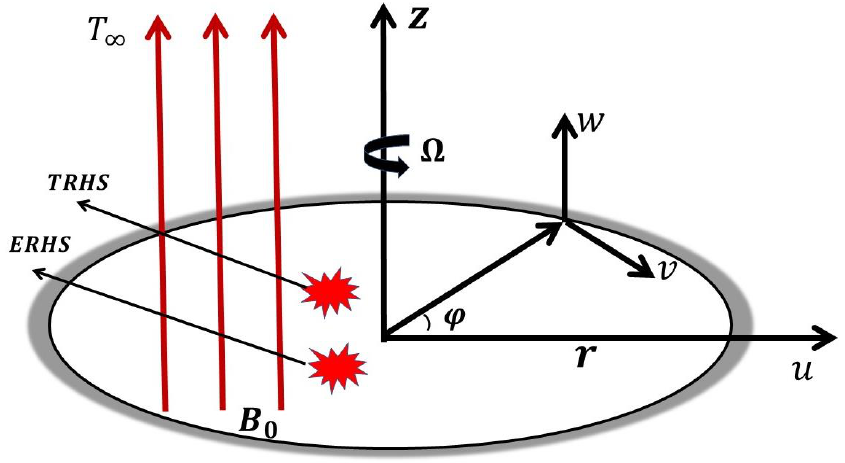
Figure 1. Physical configuration of the problem.